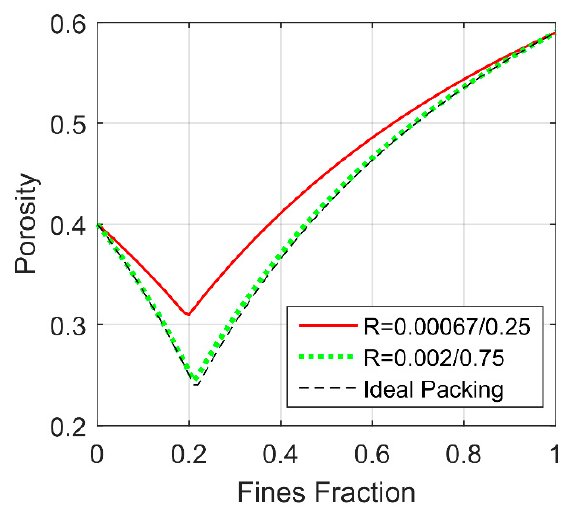
Figure 6. Porosity as function of fines fraction as predicted by current model for two cases: the first one (green dotted curve) d l = 0.75 mm and d f = 0.002 mm, while the second case (red solid curve) d l = 0.25 mm and d f = 0.00067 mm. R is the same for both cases but the green curve is much closer to the ideal packing case (dashed black curve). n l and n f = 0.4 and 0.59 respectively for all